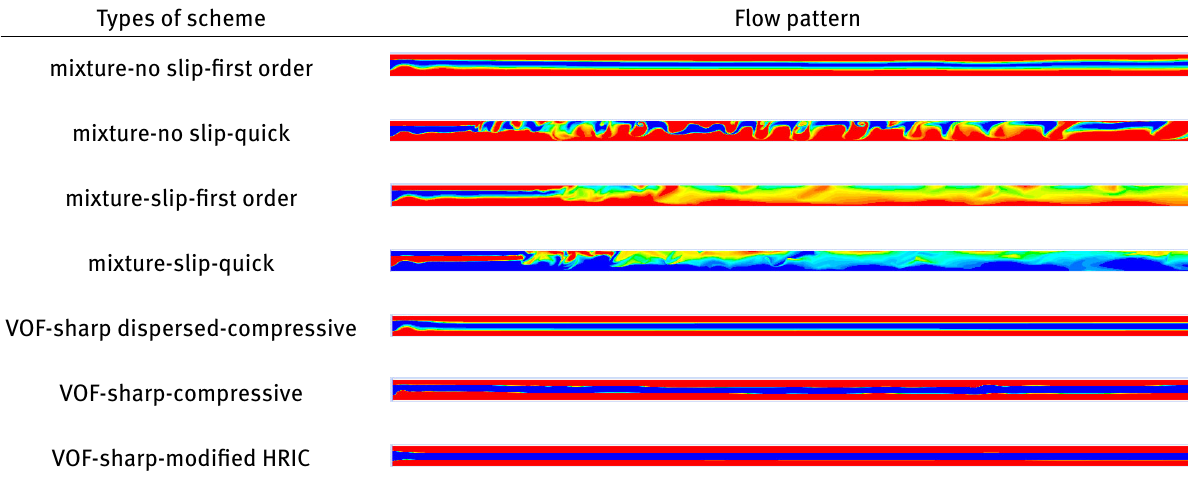
Table 17: Inter the kerosene from the middle for two-phase flow patterns, (L = 3 m, H = 7.5 cm), mesh (1,040,000) Types of scheme